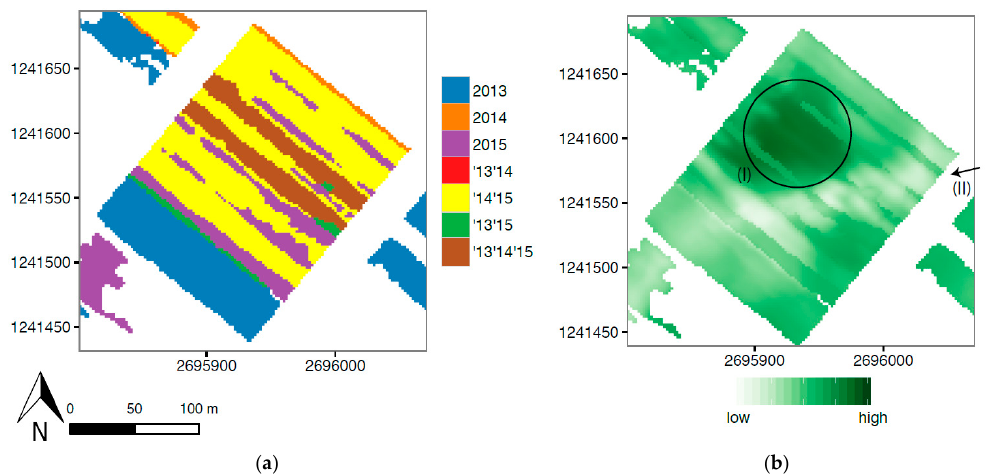
Figure 9. Close-up of an individual agricultural field showing the year(s) each bare soil pixel was present ( a ); and the first PC of the multi-temporal composite ( b ). present ( a ); and the first PC of the multi-temporal composite ( b